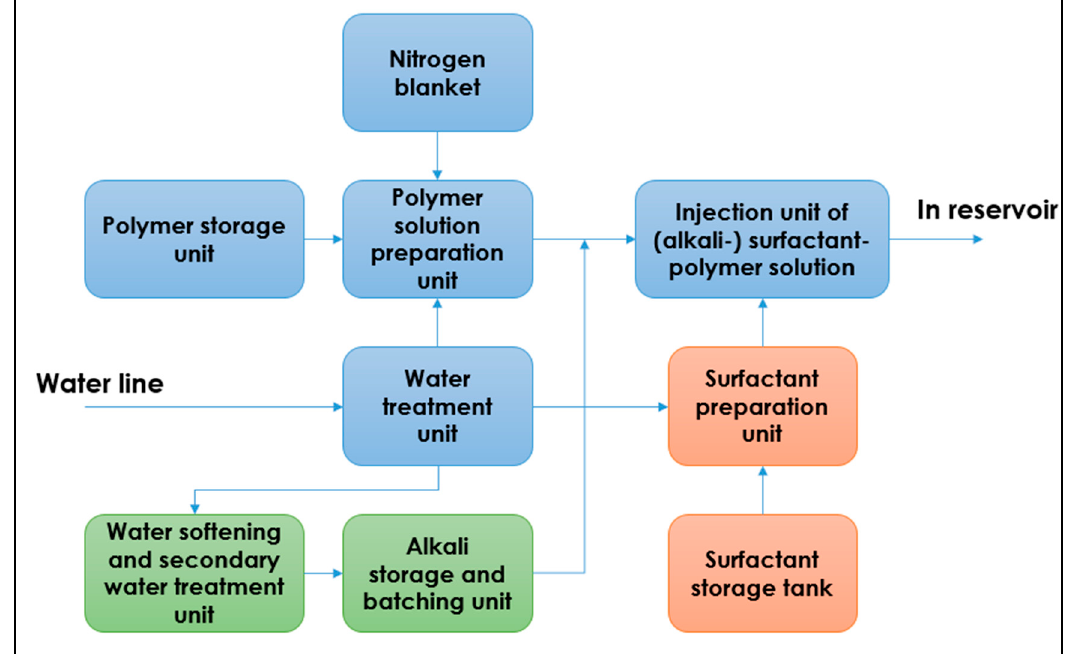
Figure 4. Flow sheet of surfactants injection [designed by authors].